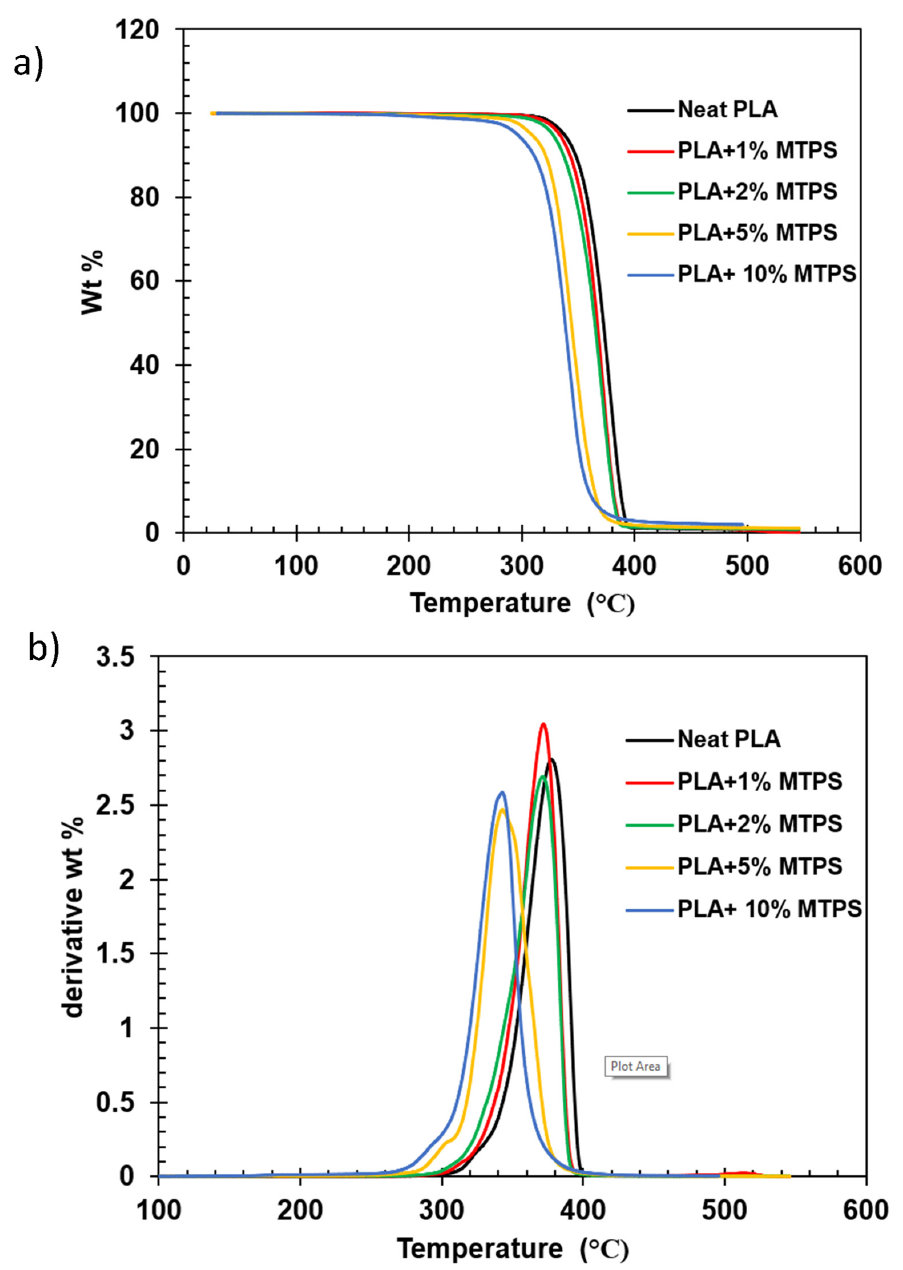
Figure 7. ( a ) TGA and( b ) DTG curves for PLA and PLA/MTPS blends. Table 6. Thermogravimetric analysis (TGA) of PLA and blends.